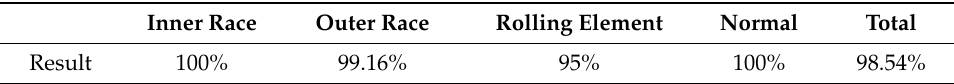
Figure 10. The Mahalanobis distances (MDs) between benchmark and testing data: ( a ) The MDs between benchmark (Inner race) and testing data; ( b ) The MDs between benchmark (Outer race) and testing data; ( c ) The MDs between benchmark (Rolling element) and testing data; ( d ) The MDs between benchmark (Normal) and testing data. Table 7. The recognition